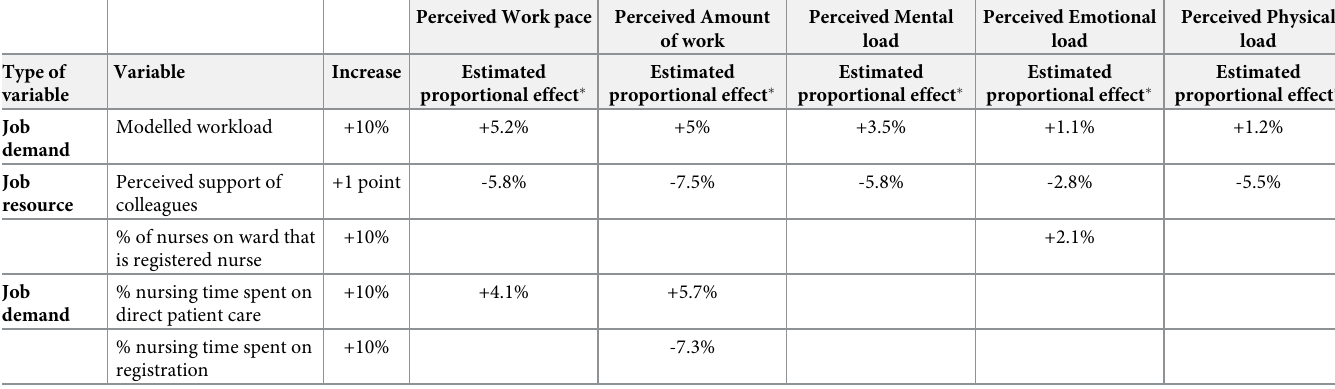
Table 3. Proportional effects for variables with significant effect on perceived